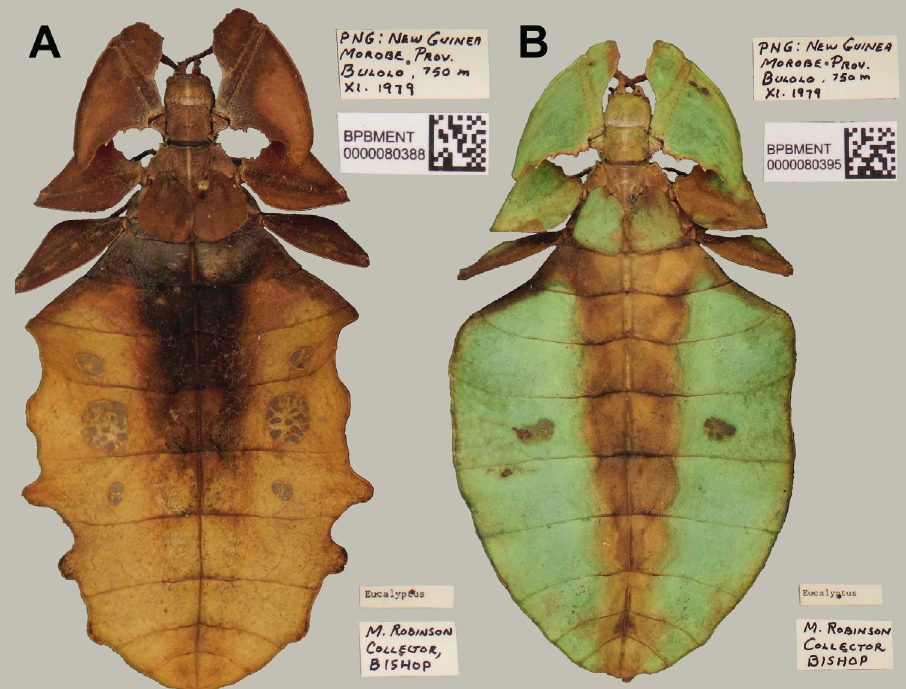
Figure 14. Examples of abdominal variation observed within Acentetaphyllium brevipenne comb. nov. adult females from within the BPBM collection, dorsal habitus, with their associated data labels to the right of each specimen. Photographs by Miho Maeda, Jerilynn Chun, and James Boone, 2020 (BPBM) A brown form with distinct eye spots on three of the abdominal segments, and a notably lobed abdomen B green form female with eye spots on a single abdominal segment and an abdominal shape which has smoother